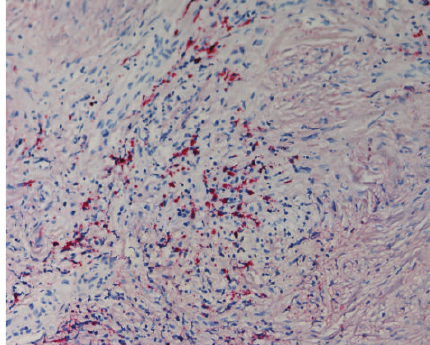
Figure 4: Immunohistochemical staining for IgG4 positive plasma cells. They were found in the same area as in Figure 3. They appear in red. ×